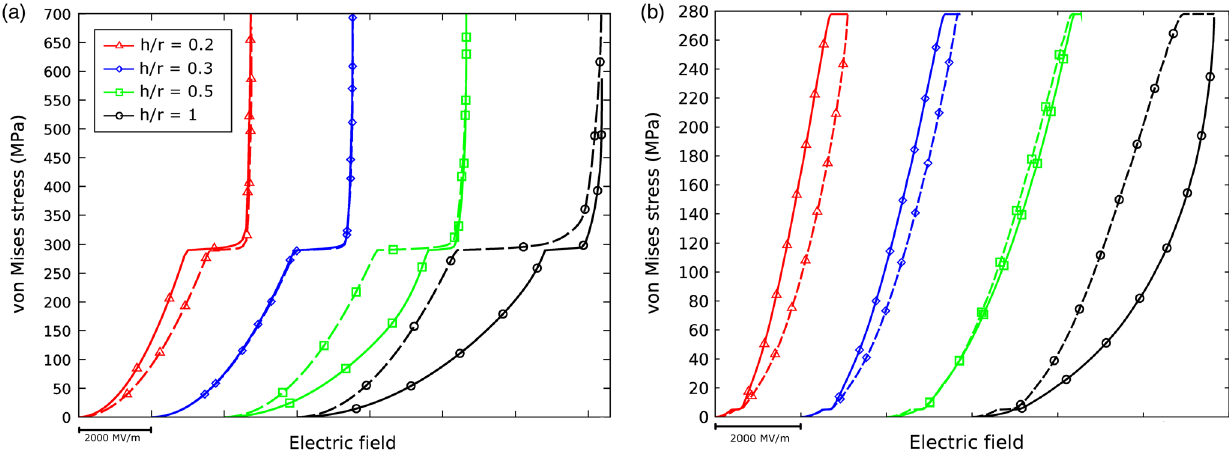
FIG. 7. Maximum von Mises as the function of the external electric field in the stainless steel and the annealed copper cells at the material (solid lines) and at the void (dashed lines) surfaces. The results are given for the voids with aspect ratio from 0.2 to